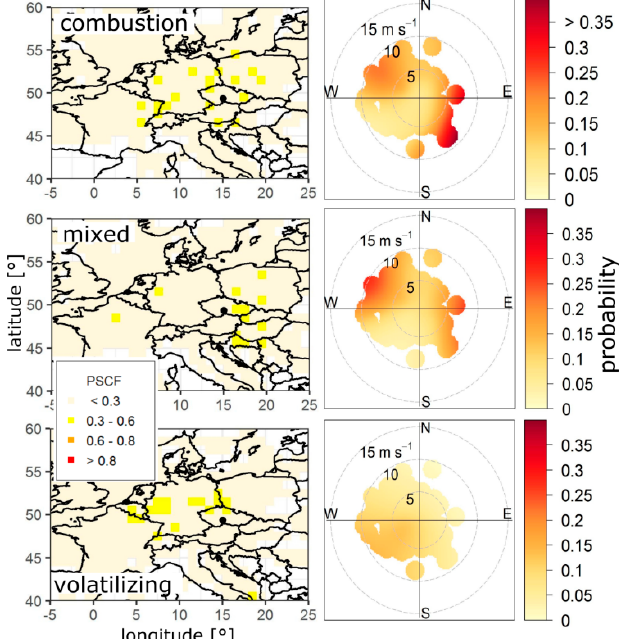
Figure 6. Sources of positive matrix factorization (PMF) factors in the warm period of the year, determined using the potential source contribution function (PSCF) method on the left and conditional bivariate probability function (CBPF) method, displayed as probability, on the right.